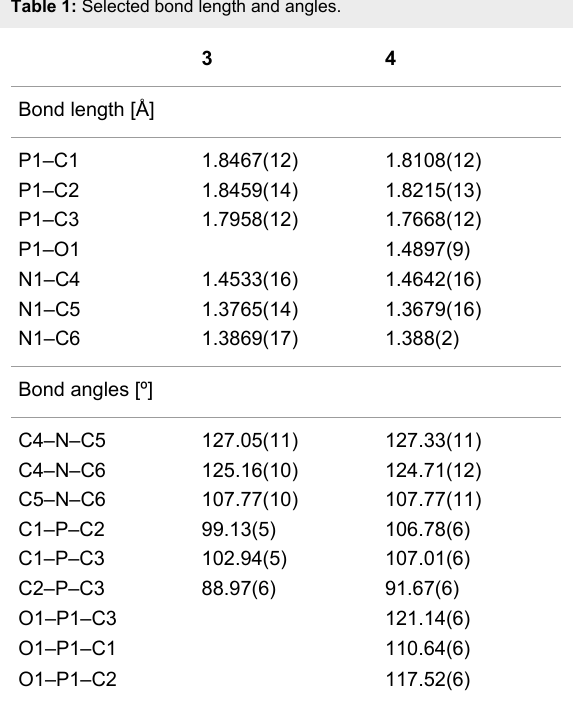
Table 1: Selected bond length and angles.